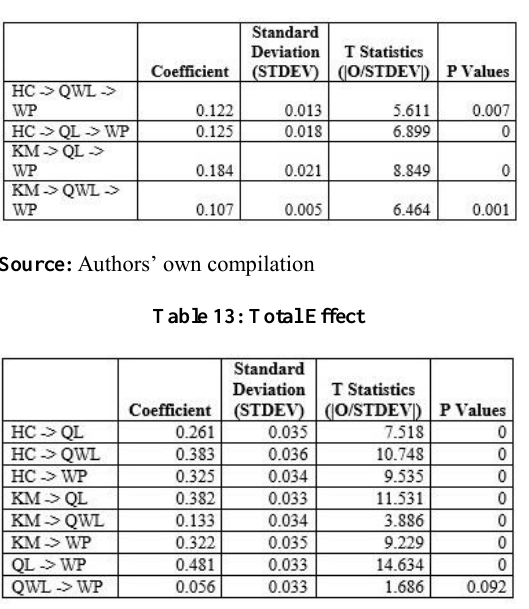
Table 12: Specific Indirect Effects